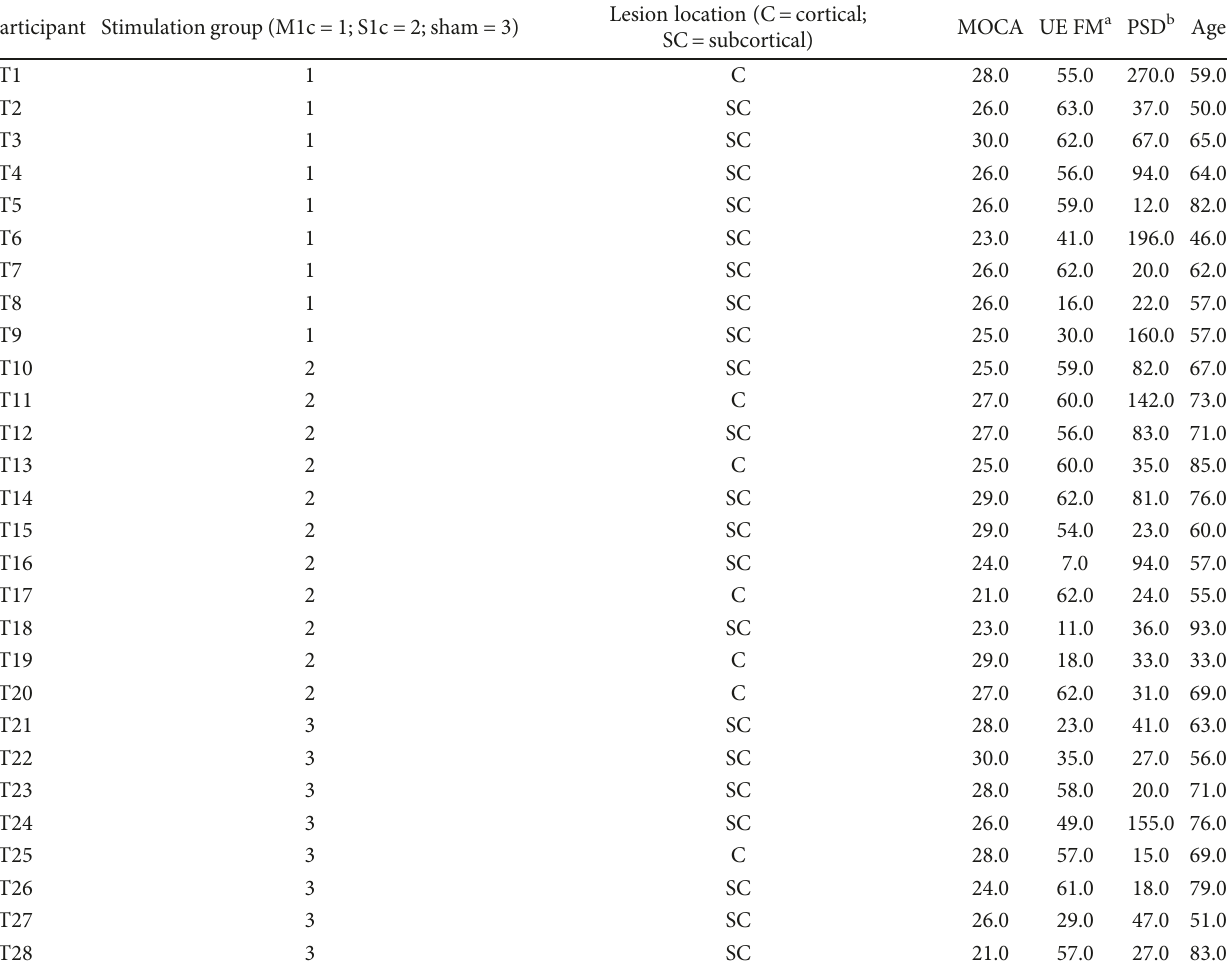
Table 1: Participant